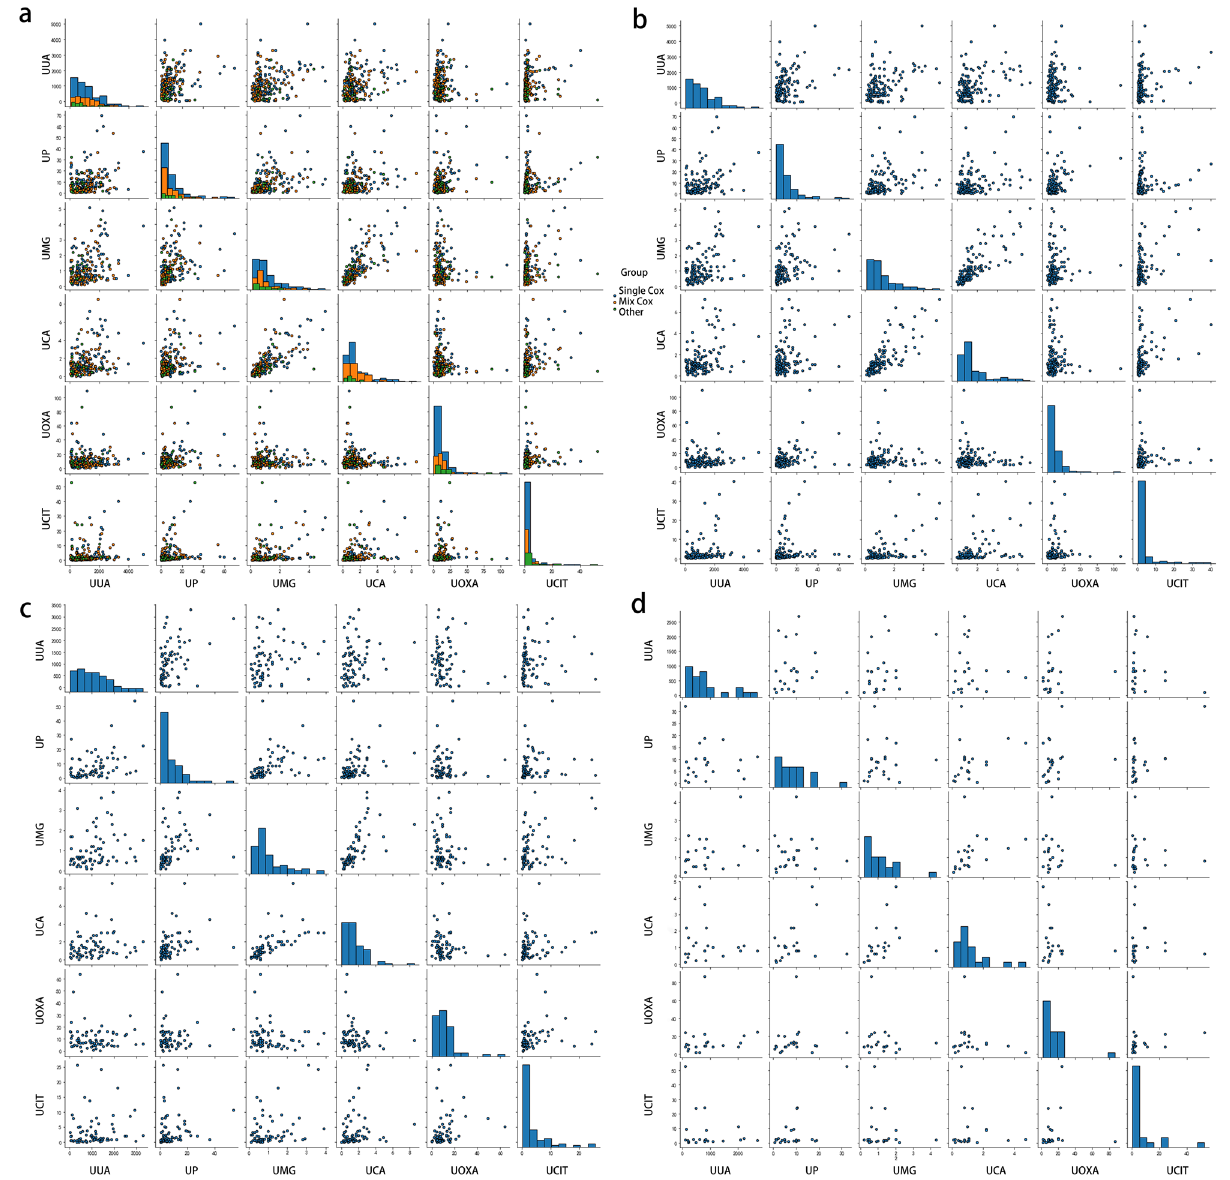
Figure 2. Risk factors were analysed through the multivariate logistic analysis between normal controls with all cases ( a ) or the single calcium oxalate group ( b ) or mixed calcium oxalate group ( c ) or other stone group ( d ), respectively. The figure was performed using Python software version 3.8 (https:// www. python.